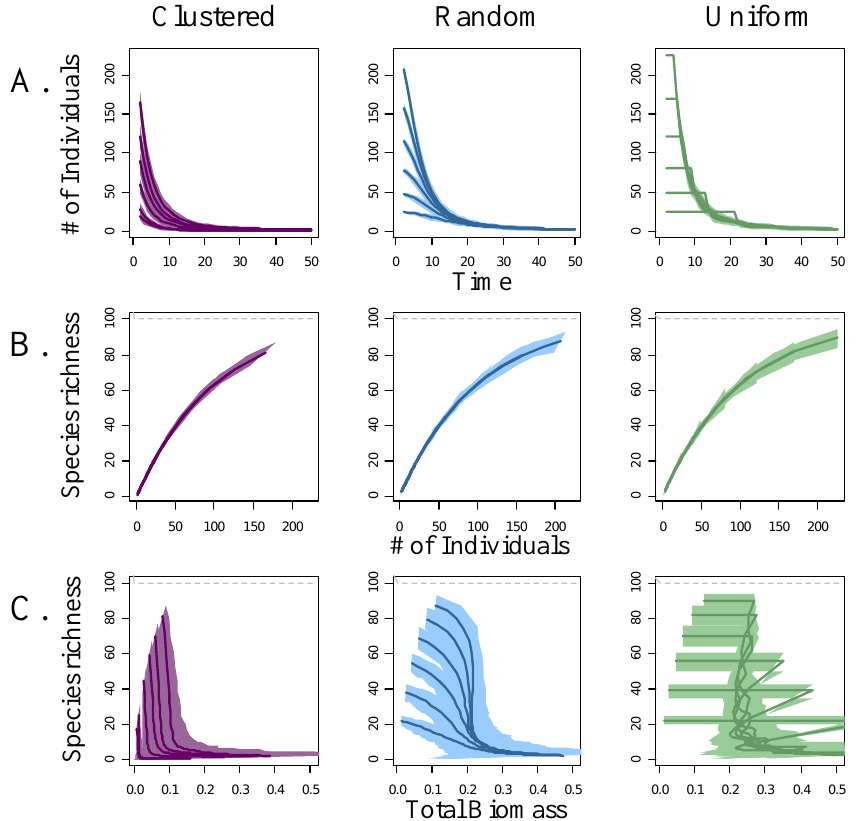
Figure 2. Three bivariate relationships generated by the simulation model are illustrated below. As in Figure 1, each column of the panel depicts the results for a different initial spatial distribution. Each line represents the average trajectory of 200 trials for a community with a given initial number of individuals. The 95 % confidence envelopes are provided around each average line (the shaded regions around the curves). Each row of the figure illustrates a different relationship: (a) the decrease in the number of individuals through time, (b) the monotonic relationship between the number of individuals in a community and species richness, and (c) the richness-biomass relationship. The dotted grey line that appears in B and C indicates the size of the species